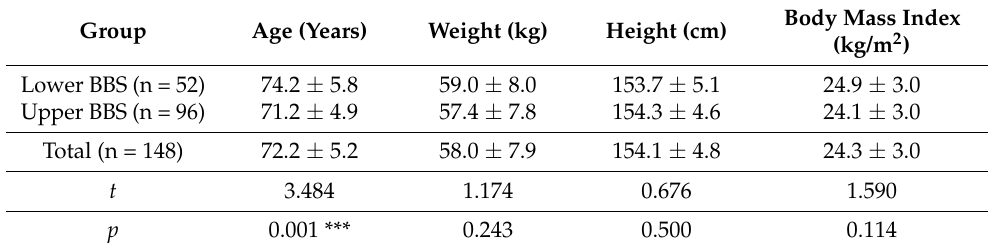
Table 1. Physical characteristics of the study participants.